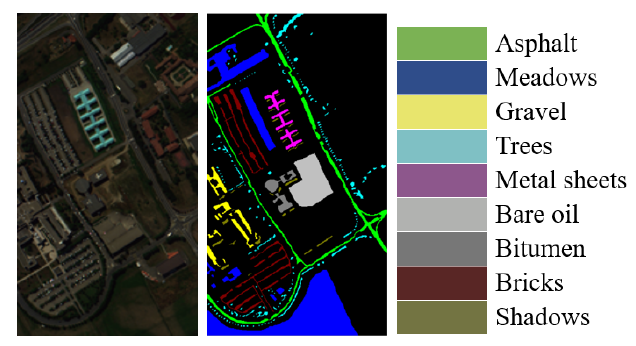
Figure 6. ( Left ) False color image and ( Right ) ground truth map of the University of Pavia